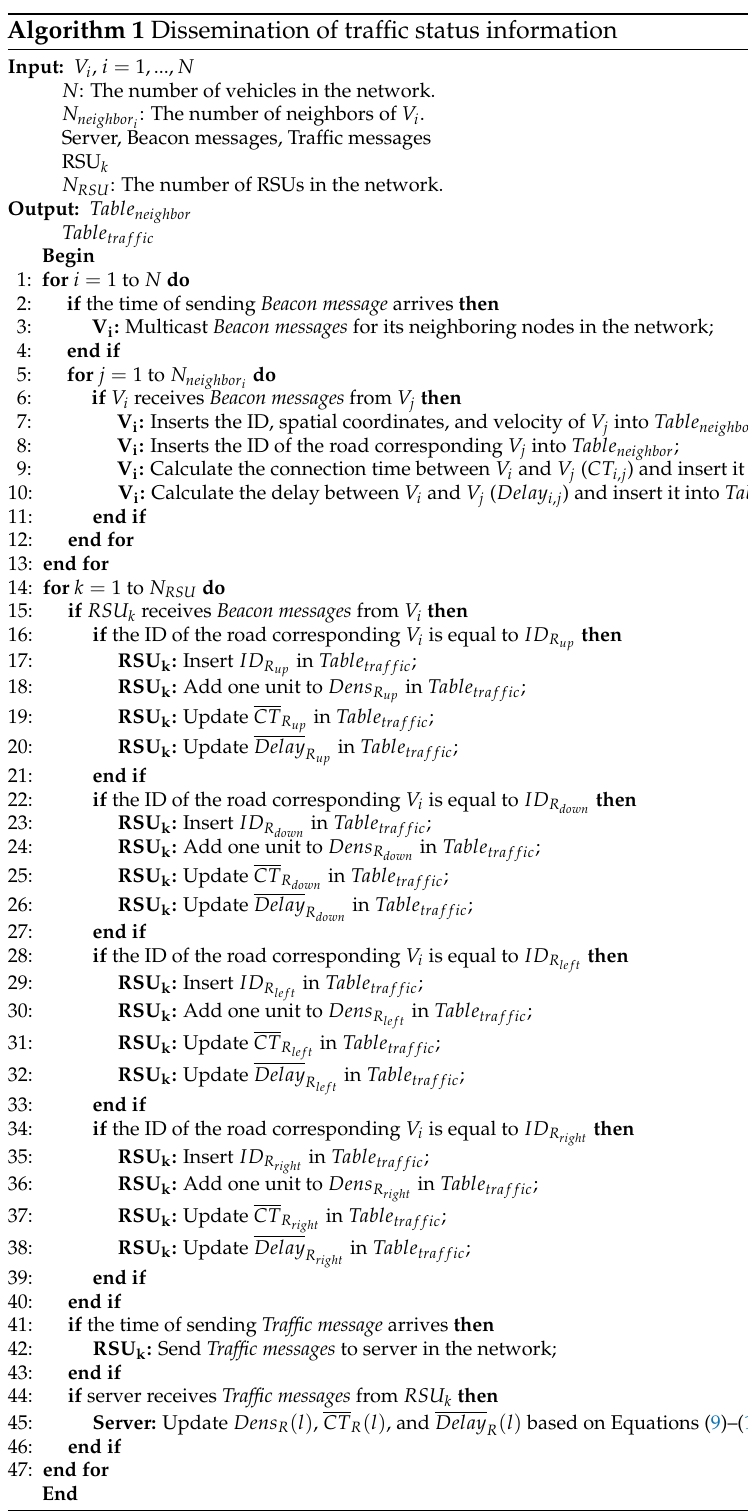
Algorithm 1 Dissemination of traffic status